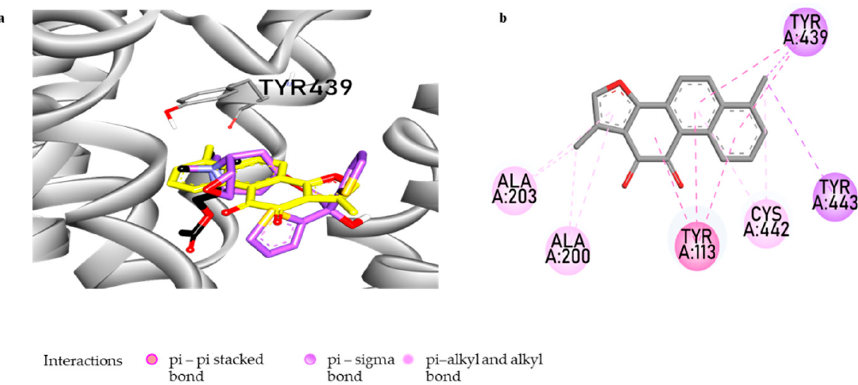
Figure 6. Prediction of the binding modes of tanshinone I with hM 4 R by molecular docking. Close-up view of tanshinone I at the orthosteric binding site of hM 4 R ( a ). Tanshinone-I, acetylcholine, and tiotropium are shown as yellow, black, and purple sticks, respectively. 2D-binding diagram showing ligand–receptor interactions at the catalytic hM 4 R by tanshinone I ( b ).